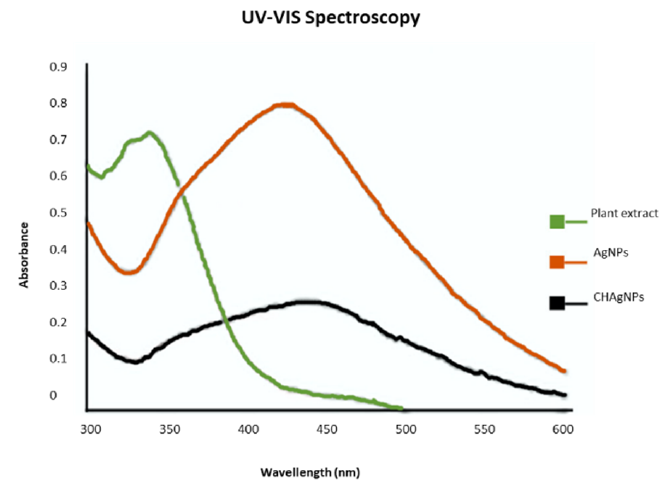
Figure 1. UV–Vis absorption spectra of synthesized AgNPs (429 nm) and CH ‐ AgNPs (445 nm).